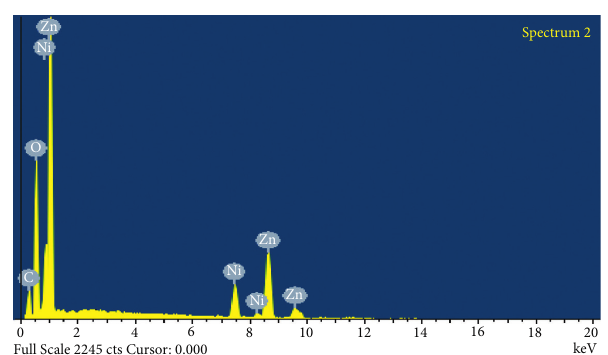
Figure 7: EDX spectrum of NiO-ZnO